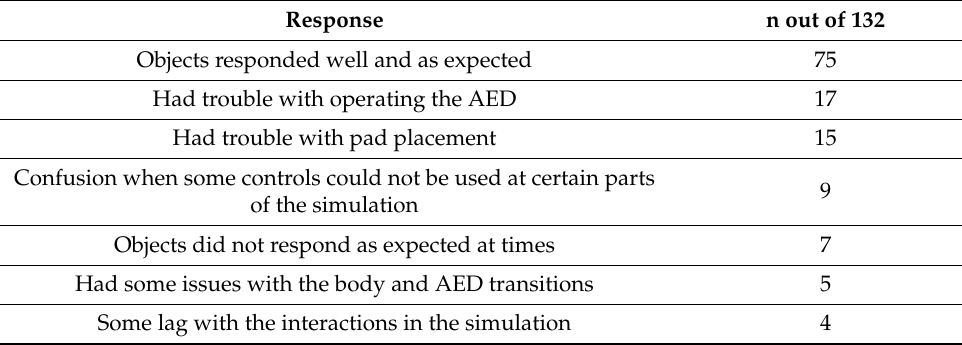
Table 7. Did the controls and objects of the simulation operate and behave as